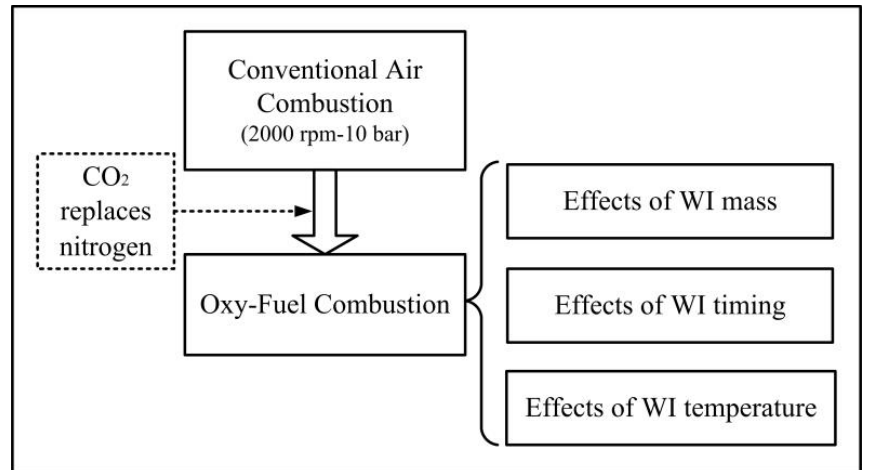
Figure 2. Flow chart of the research approach.